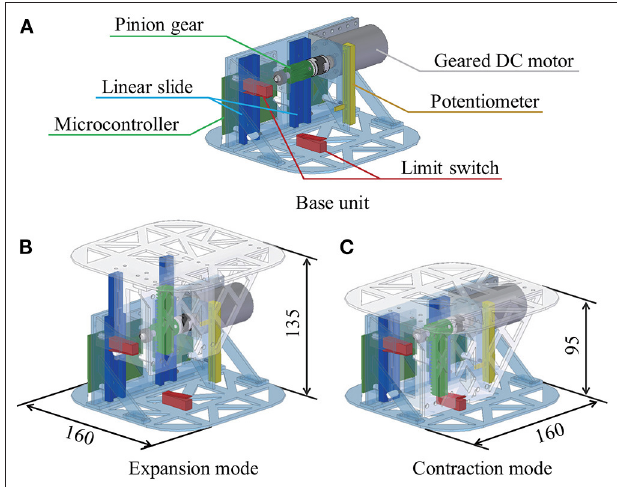
FIGURE 2 | Hardware configuration and respiratory motion. The device consists of a base unit (A) and a top panel unit, and the top panel unit moves up and down as shown in (B,C) by meshing the pinion gear connected to the motor set in the base unit with the rack set in the top panel unit.